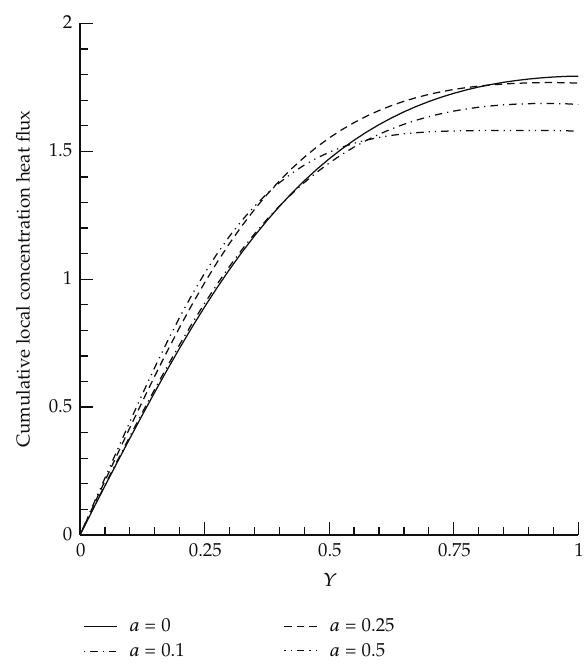
Figure 7: Cumulative mass flux plots along the left vertical wall while fixing Le (cid:8) 1, B (cid:8) 1, (cid:2) D/H (cid:3) (cid:8) 0 . 1, Ra (cid:8) 100, S C (cid:8) 0 . 1 for di ff erent values of “ a